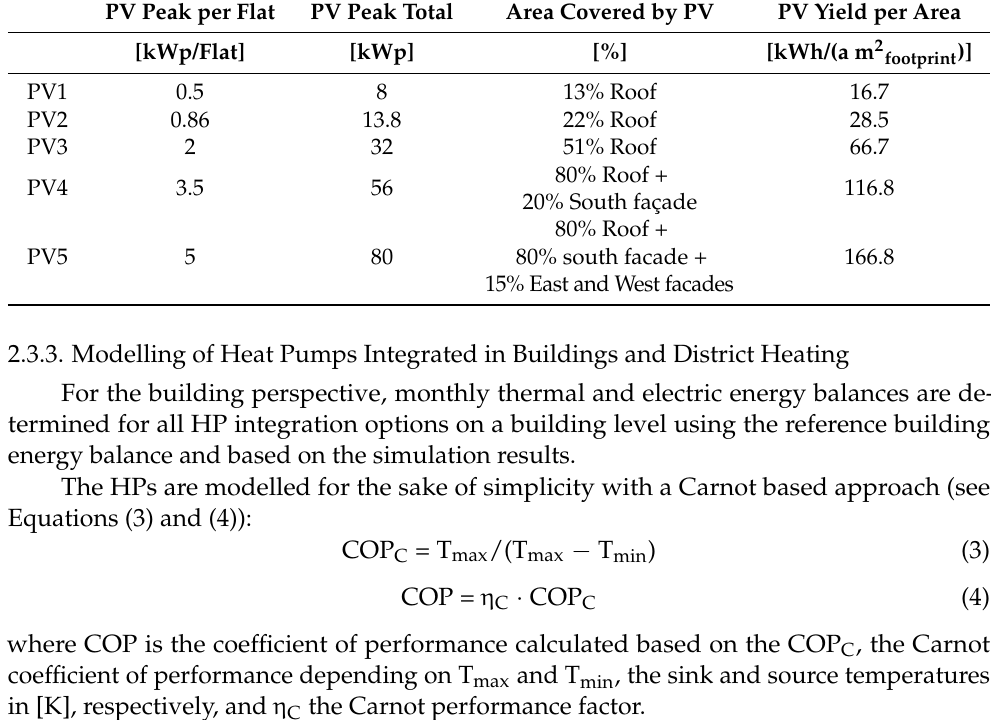
Table 7. PV peak power, percentage of areas covered with PV modules [36] and PV yield per area for the different variants of PV; reference building with 16 flats and a roof area of 449.4 m 2 . PV Peak per Flat PV Peak Total Area Covered by PV PV Yield per